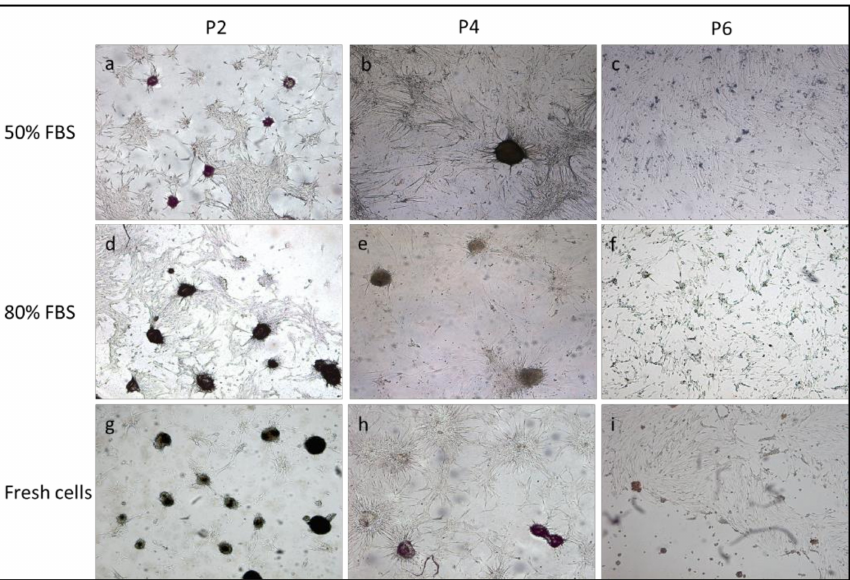
Figure 5. Deposition of calcified extracellular matrix revealed by von Kossa staining in cAD-MSCs, cryopreserved with 10% DMSO–50 and 80% FBS and thawed, cultured with osteogenic differentiation medium at passages P2 ( a , d ), P4 ( b , e ). The frozen cells showed the same differentiation potential as fresh cells at each passage ( g , h , i ). A 100 ×